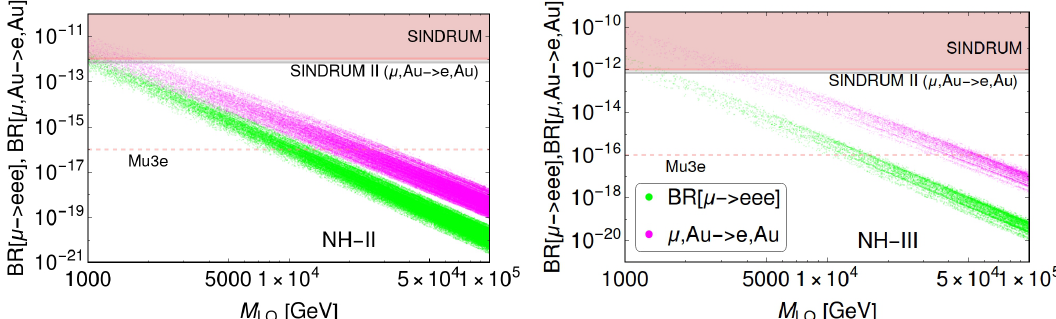
Figure 6 . BR ( µ → eee ) and BR ( µ − e ) conversion as a function of the common LQ mass. Shaded colored regions are ruled out by current data and dotted lines represent future